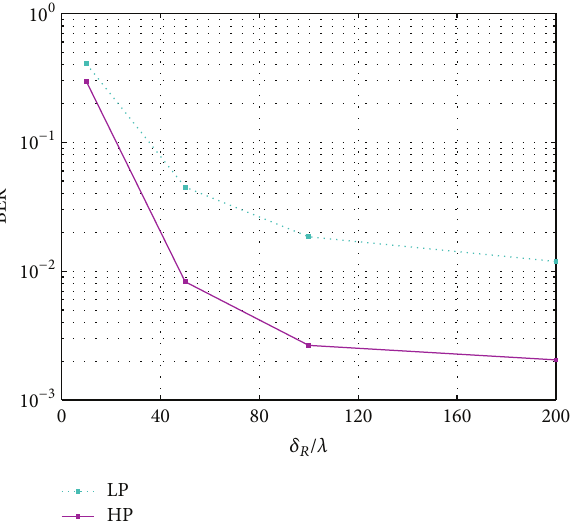
Figure 7: BER for increasing values of the antenna spacing at the stratospheric